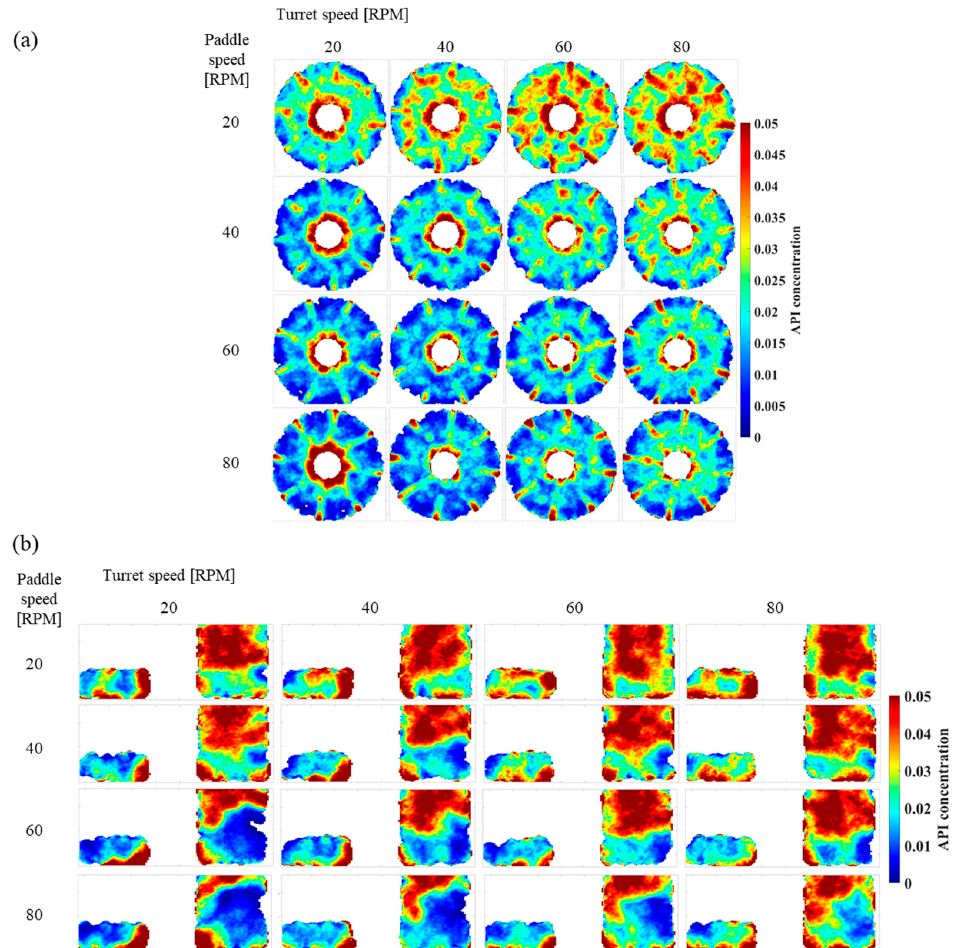
Figure 14. Continuous spatial plots showing the API (the smallest particle) distribution in the feed frame where each column corresponds to a different turret speed and each row corresponds to a different paddle speed: ( a ) top view plane at 16 different paddle and turret speeds; ( b ) side view plane at 16 different paddle and turret speeds (left: half of the chamber; right: half of the chamber and the hopper). Blue color indicates smaller API concentration, and red color indicates larger API concentration.